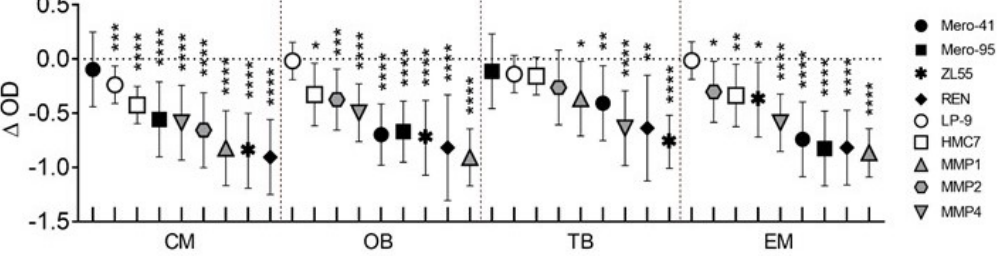
Figure 3. Evaluation of CM, OB, TB, and EM with MTT assay for cell viability carried out on a second set of cell lines. Y -axis reports the average difference (as dots) and its confidence interval (as whiskers) between the optical densities (OD) measured after 72 h in treated and control cultures. Drugs were assayed at the same doses employed in the first set of cell lines (i.e., CM, 0.1 μ M; OB, 0.1 μ M; TB, 1 μ M; EM, 0.1 μ M) and the correspondences are: (i) black dots, permanent MPM cell lines, (ii) white dots, cultures of nonmalignant pleural cells, and (iii) grey dots, primary MPM cell lines. Data are reported as mean and its confidence intervals of three independent experiments. When the differences were statistically significant, their divergence from 0 were represented by asterisks, as * = p < 0.05; ** = p < 0.01; *** = p < 0.001, and **** = p < 0.0001.